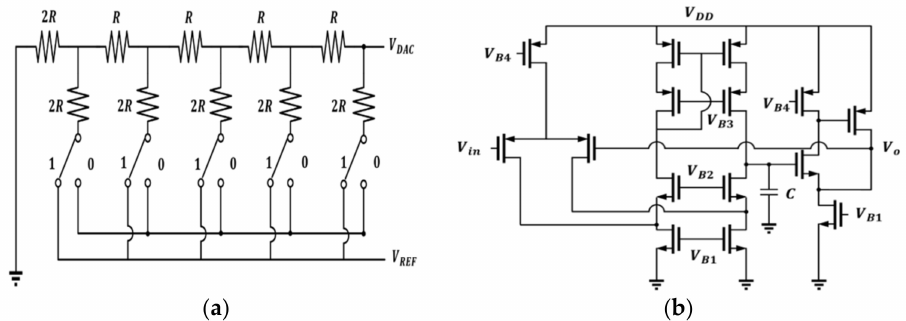
Figure 13. ( a ) The resistor-2resistor ladder (R-2R) digital-to-analog (DAC) circuit; ( b ) schematic of the unit gain voltage follower. V DAC , the voltage of digital-to-analog converter; V REF , reference voltage; V in , the input signal voltage; V O , the output voltage.